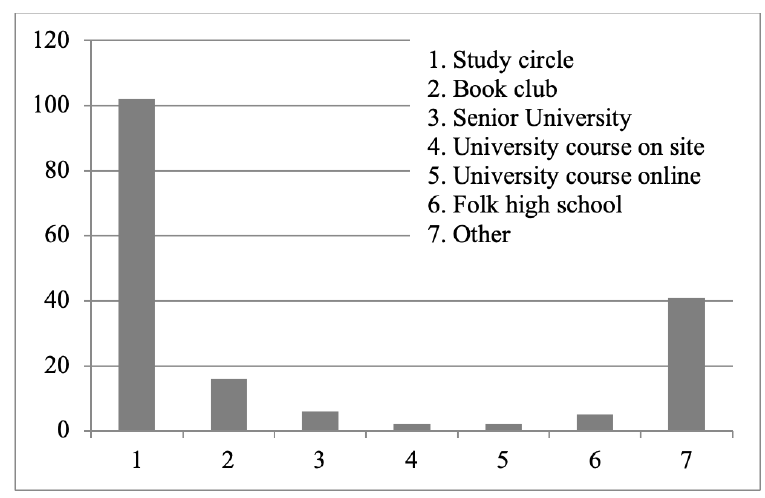
Figure 1. Participation in formal and/or non-formal education activities (multiple responses were